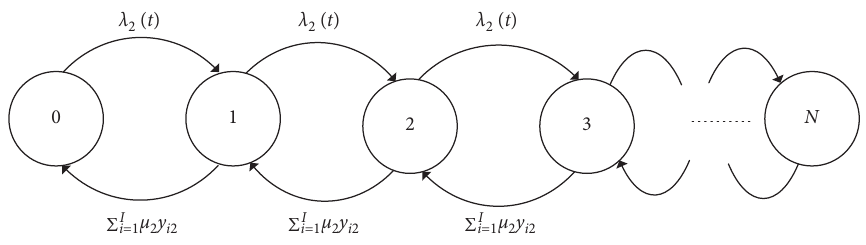
Figure 5: The state transition diagram for type 2